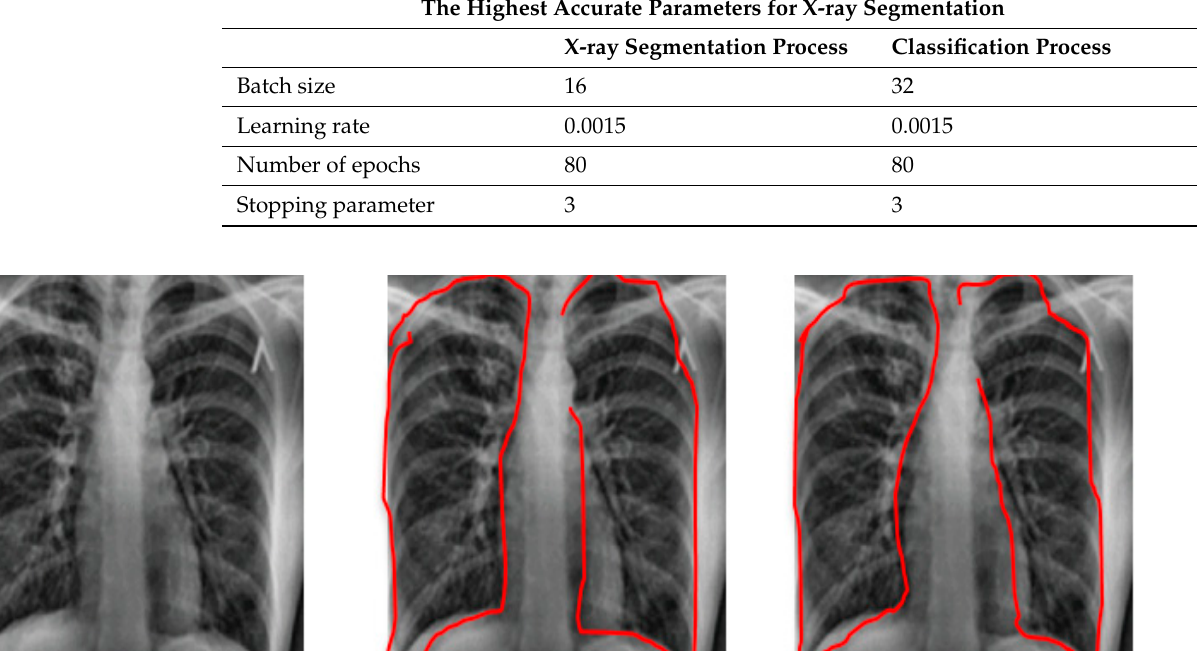
Table 7. The highest accurate parameters for X-ray segmentation.